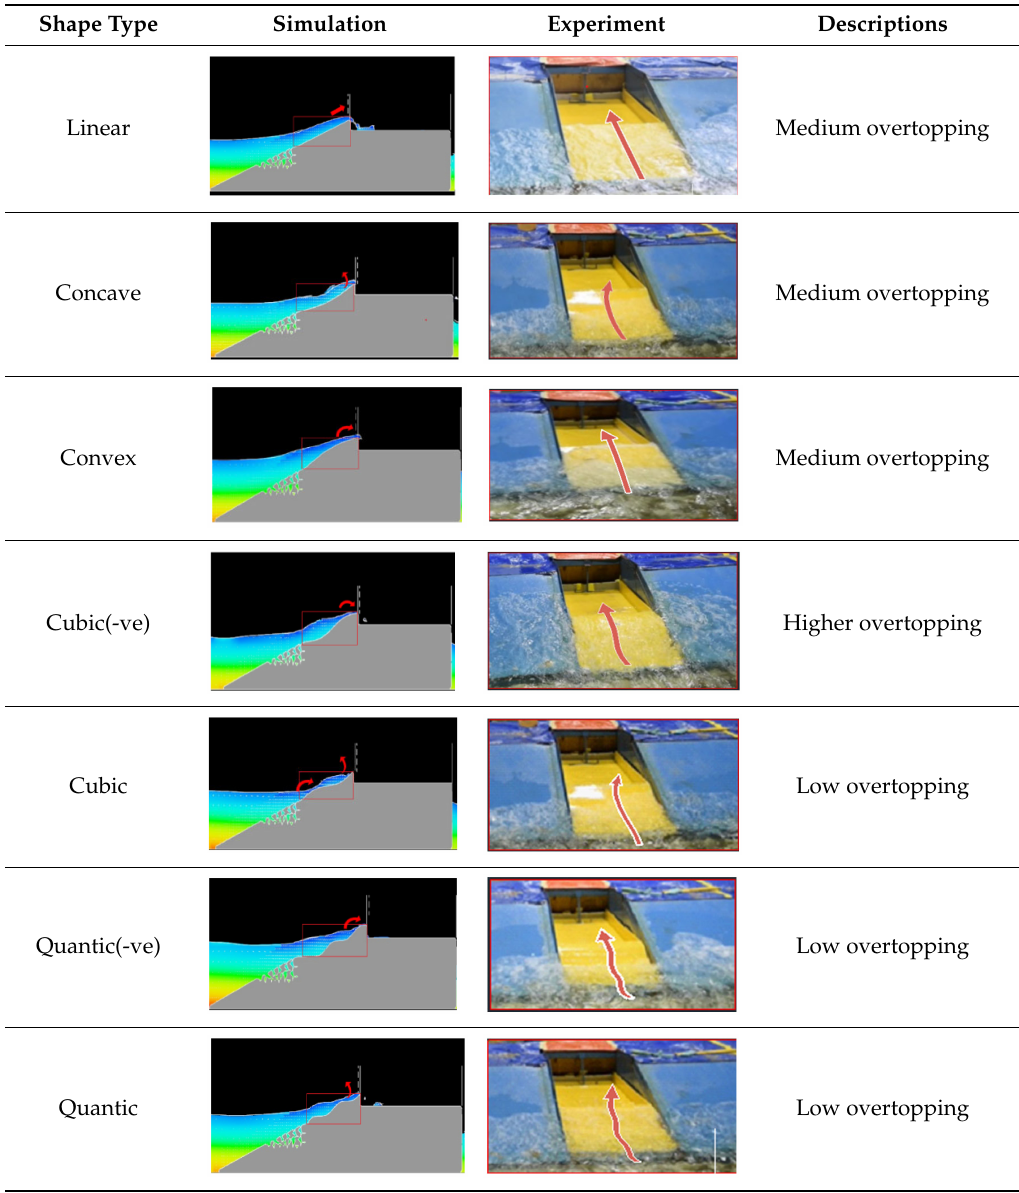
Table 4. Snapshot comparison between experiment and